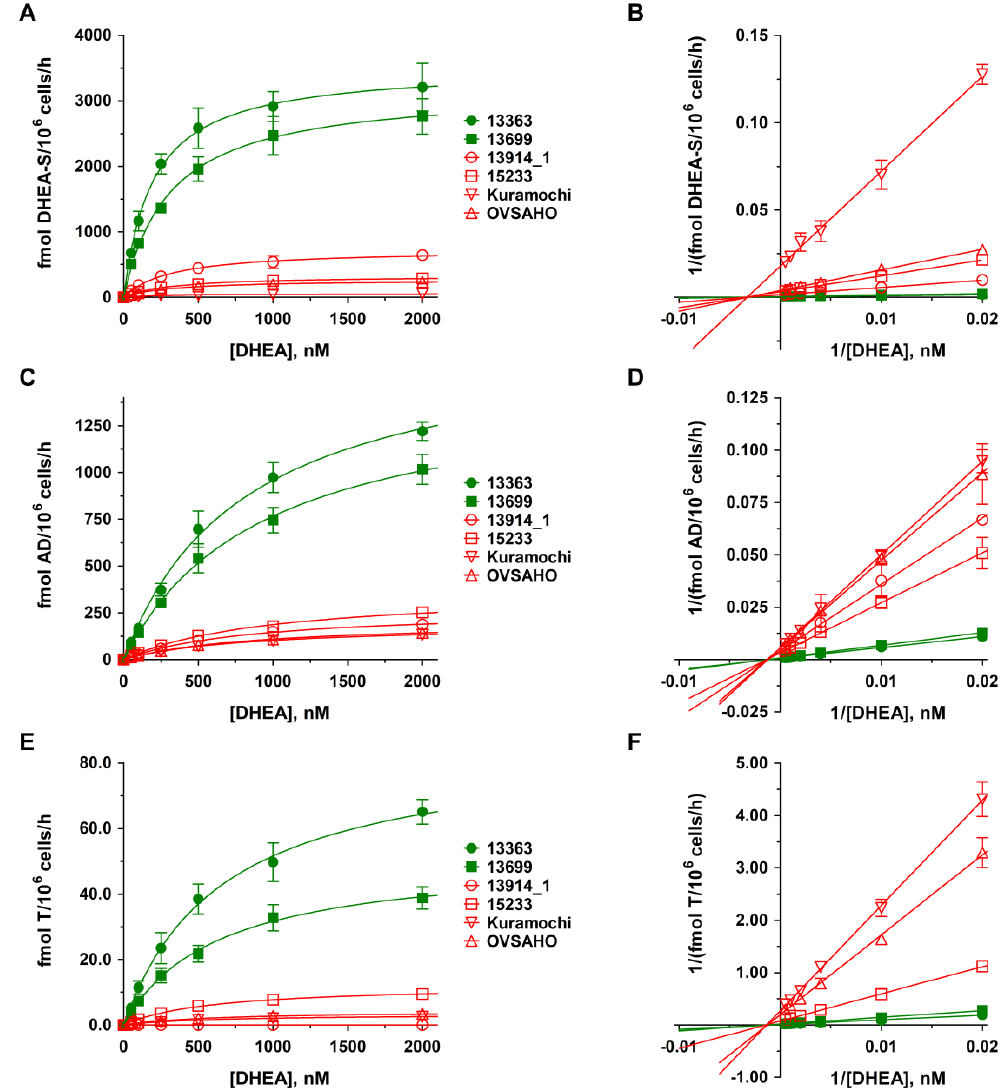
Figure 2. Kinetic profiles of dehydroepiandrosterone (DHEA) metabolite formation in platinum-sensitive and -resistant HGSOC cells. The kinetics of ( A – B ) DHEA sulfation, ( C – D ) AD formation, and ( E – F ) T formation were calculated following the incubation of all HGSOC cell lines with 0 to 2000 nM DHEA as a hormone precursor for 48 h. Data are displayed as Michaelis–Menten and Lineweaver–Burk plots and represent the means ± SD of three independent experiments. Green curves indicate sensitivity and red curves indicate resistance against carboplatin to the investigated HGSOC cell lines. Differences were statistically significant between these two groups ( p < 0.05).